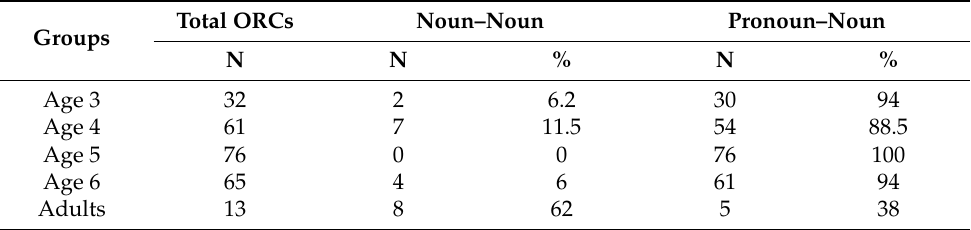
Table 6. Raw scores (N), percentages (%) of FULL ORC S with two nouns or with noun and pronoun by age group.